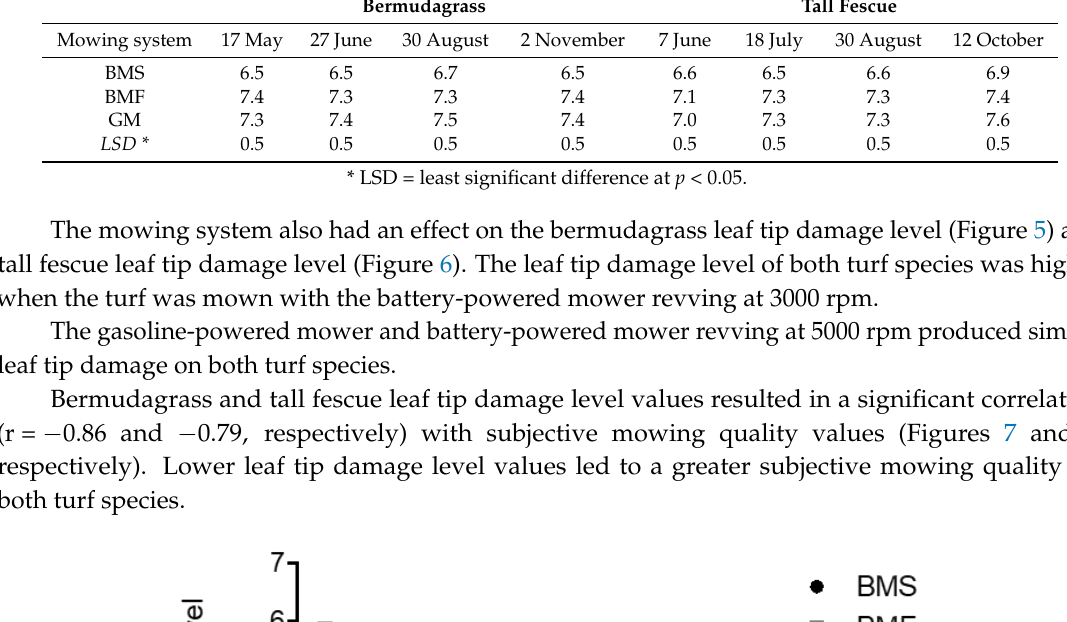
Table 3. Mowing system mean effect on bermudagrass and tall fescue subjective mowing quality (1 = poor, 9 = excellent), where BMS = battery-powered mower revving at 3000 rpm, BMF = battery-powered mower revving at 5000 rpm and GM = gasoline-powered mower.